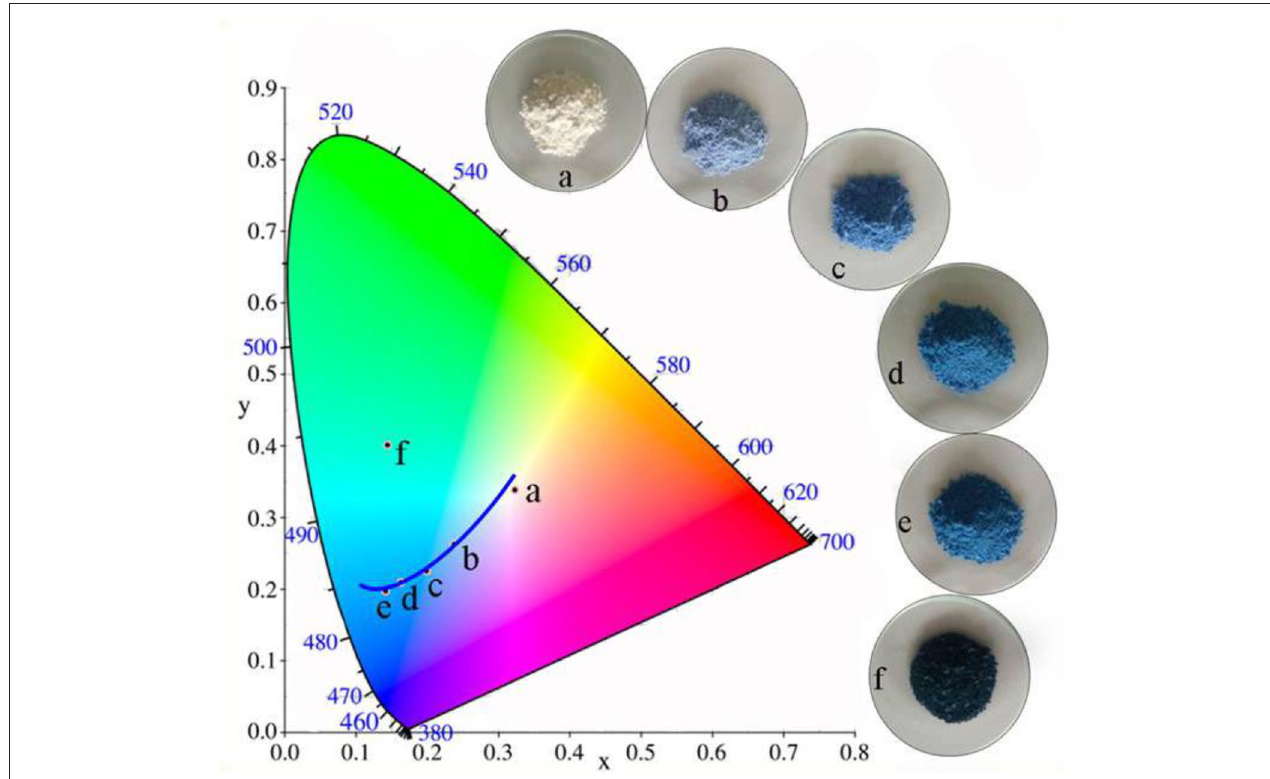
FIGURE 4 | Color coordinates of pigment prepared using the different addition of Co 3 O 4 in the presence of 2g Kaol without Al 2 O 3 (a-0%, b-2.4%, c-4.8%, d-9.1%, e-13%, f-16.7%).